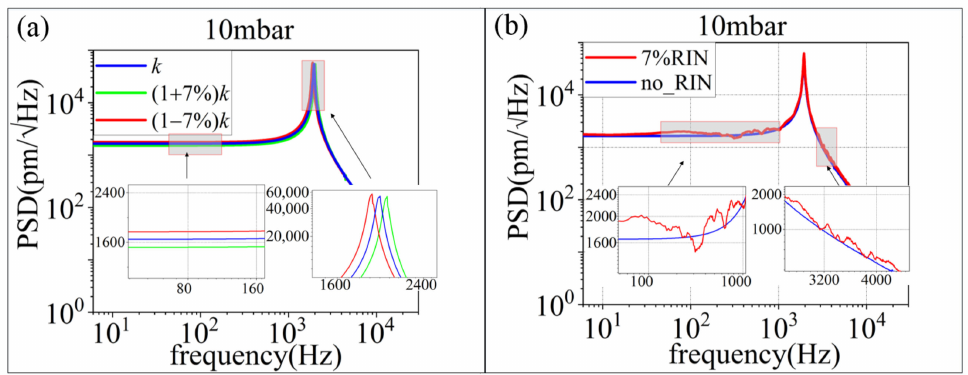
Figure 4. The simulation results of particle movement along the laser intensity fluctuation at 10 mbar. ( a ) Long-term intensity fluctuation ( b )